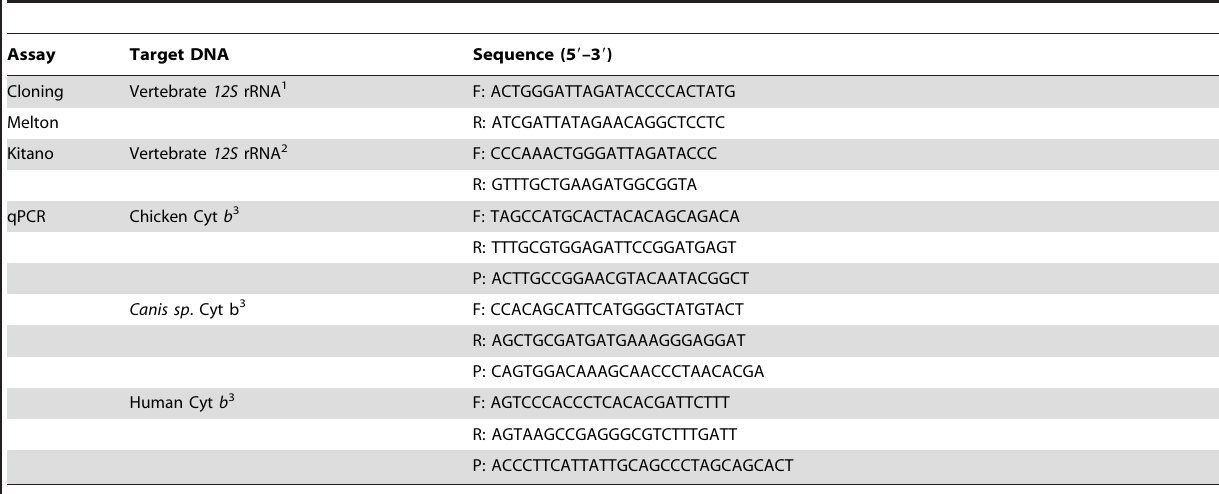
Table 1. Sequence of mitochondrial DNA primers (F = Forward, R = Reverse) and probes (P) used in cloning and qPCR assays to detect vertebrate blood meal sources in Chagas disease insect